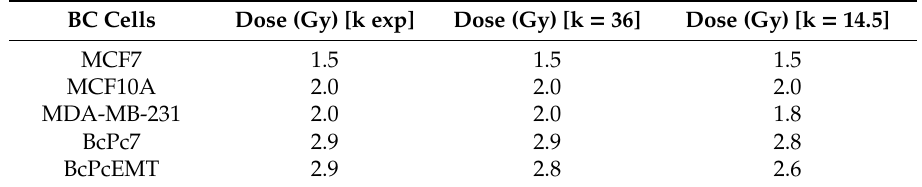
Table 2. Dose values for fraction calculated to obtain an LSR( D ) of 100% in the three conditions, analyzed with an experimental k (k exp), k = 36 and k = 14.5.